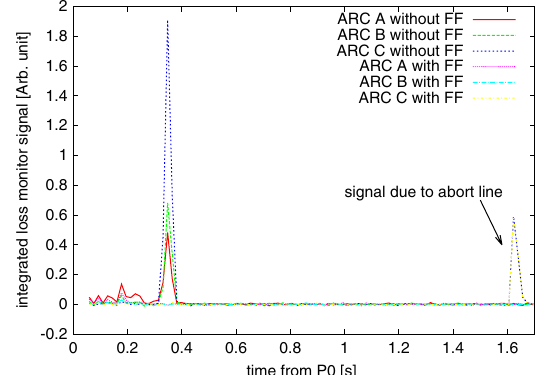
FIG. 14. Typical momentum deviation ( dp=p ) calculated by using the BPM signals (top) without and (bottom) with feedfor- ward.